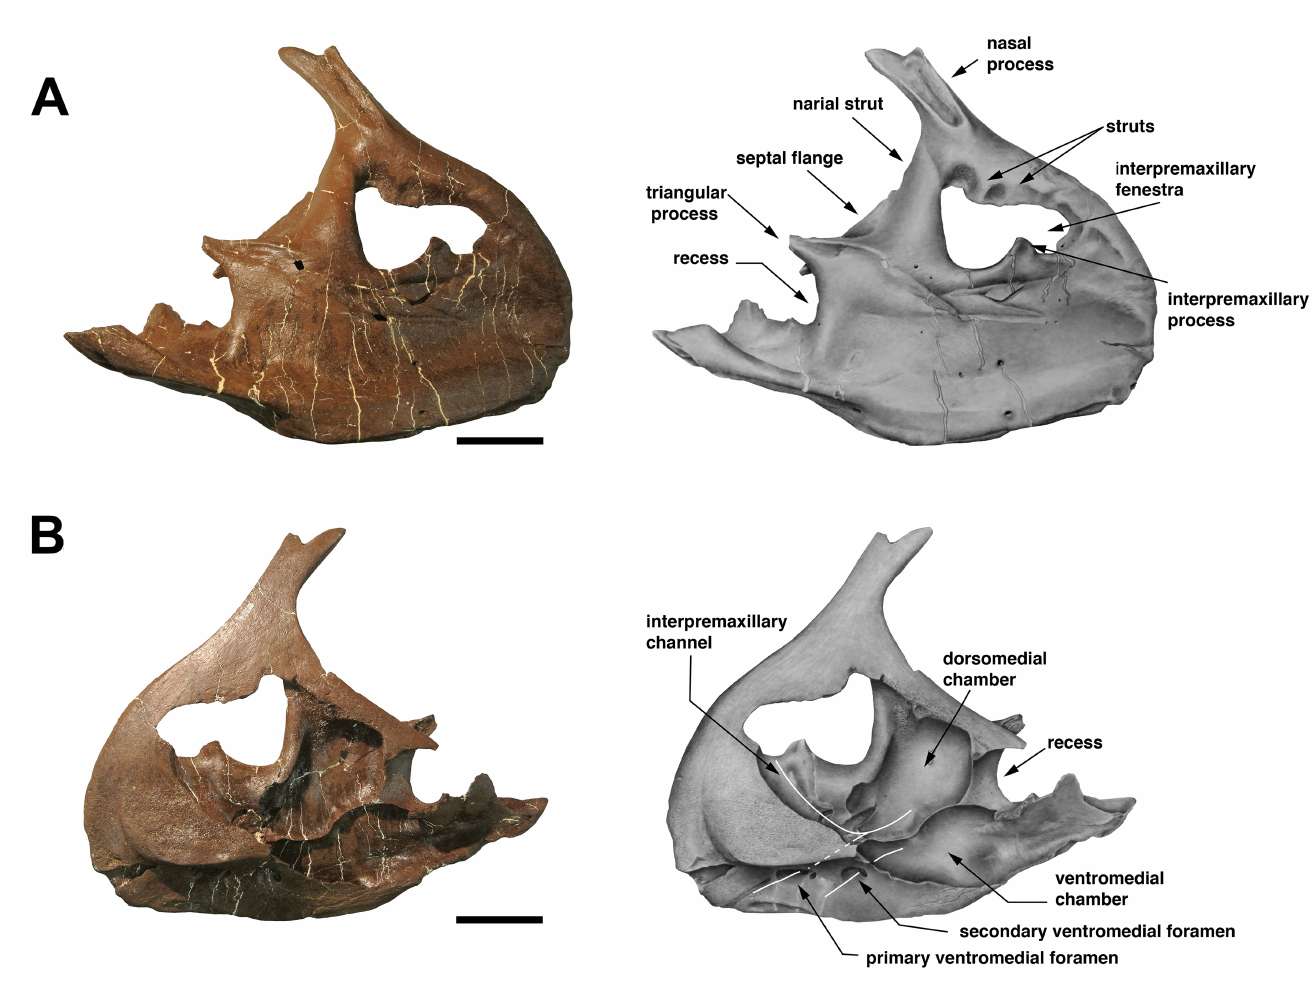
Figure 3. Photographs and illustrations of MOR 1122 7-22-00-1 in A) lateral and B) medial views. White lines indicate hy - pothesized relationships between ventromedial foramina, interpremaxillary channel, and internal chambers. Scale, 10 cm. Graphite illustrations by K.